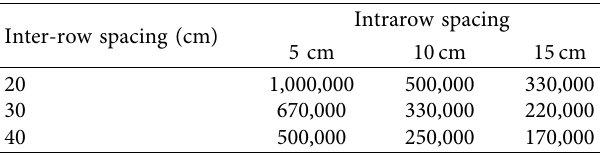
Table 2: Inter-row and intrarow spacing with corresponding plant